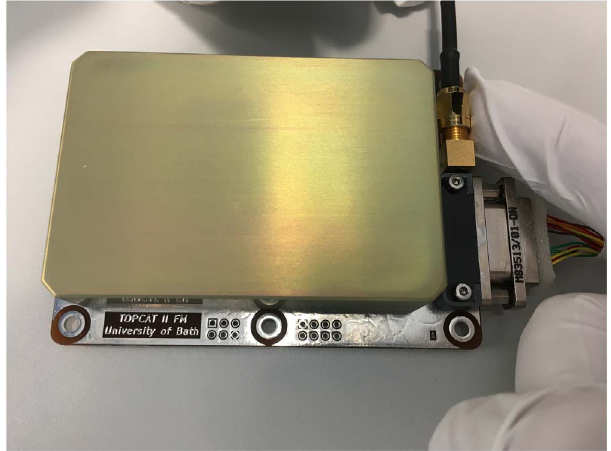
Fig. 8. TOPCAT II fl ight model. The shield protects the GPS receiver and electronic printed circuit board (courtesy University of Bath).